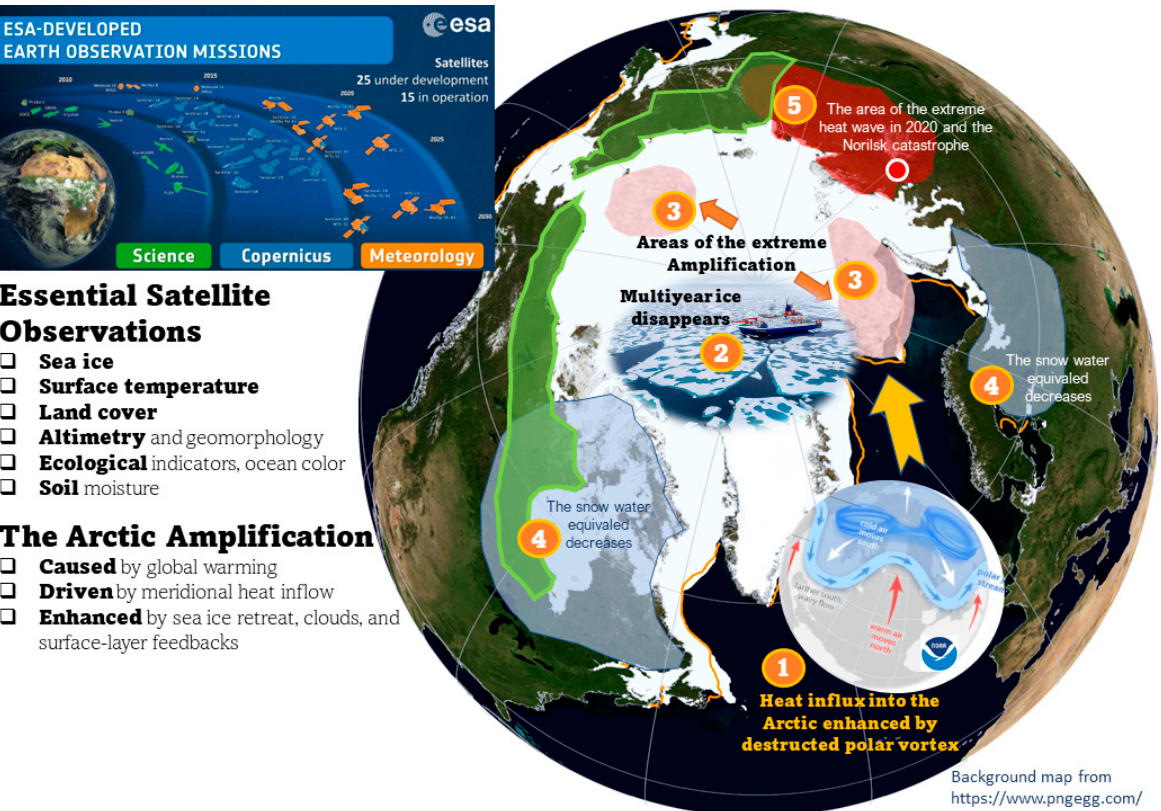
Figure 3. A schematic illustration of the ESA satellite fleet contributing to monitoring of the dynamic processes, physical feedback, and environmental impact related to the emergence of the apparent amplification.